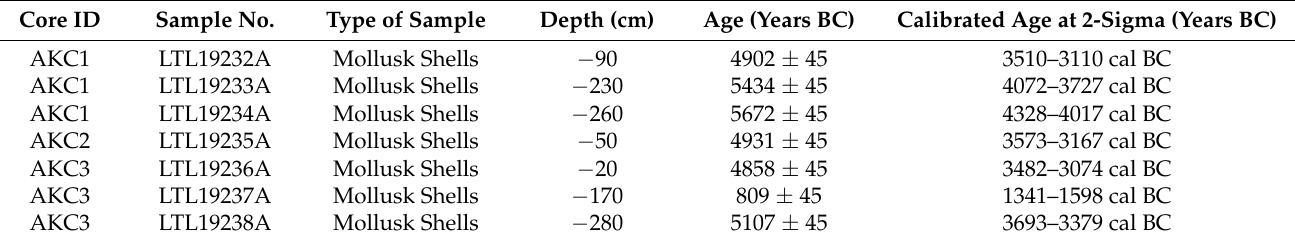
Table 2. Age determination results (at 2-sigma) of the selected samples. Age calibrated using MARINE13 curve for marine samples [67] with a DR value of − 52 ± 50 estimated for the eastern Mediterranean [68]. Core ID Sample